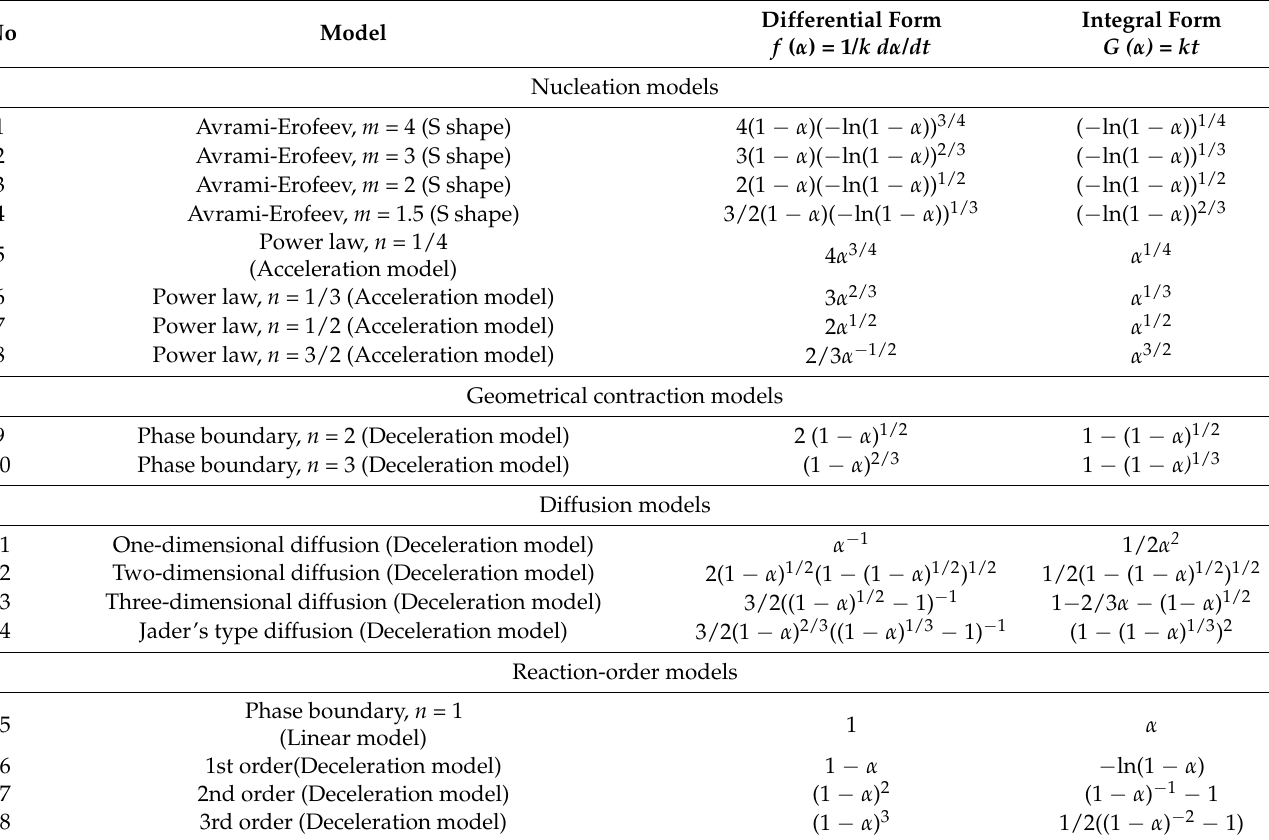
Table 1. The commonly used kinetic model of heterogeneous